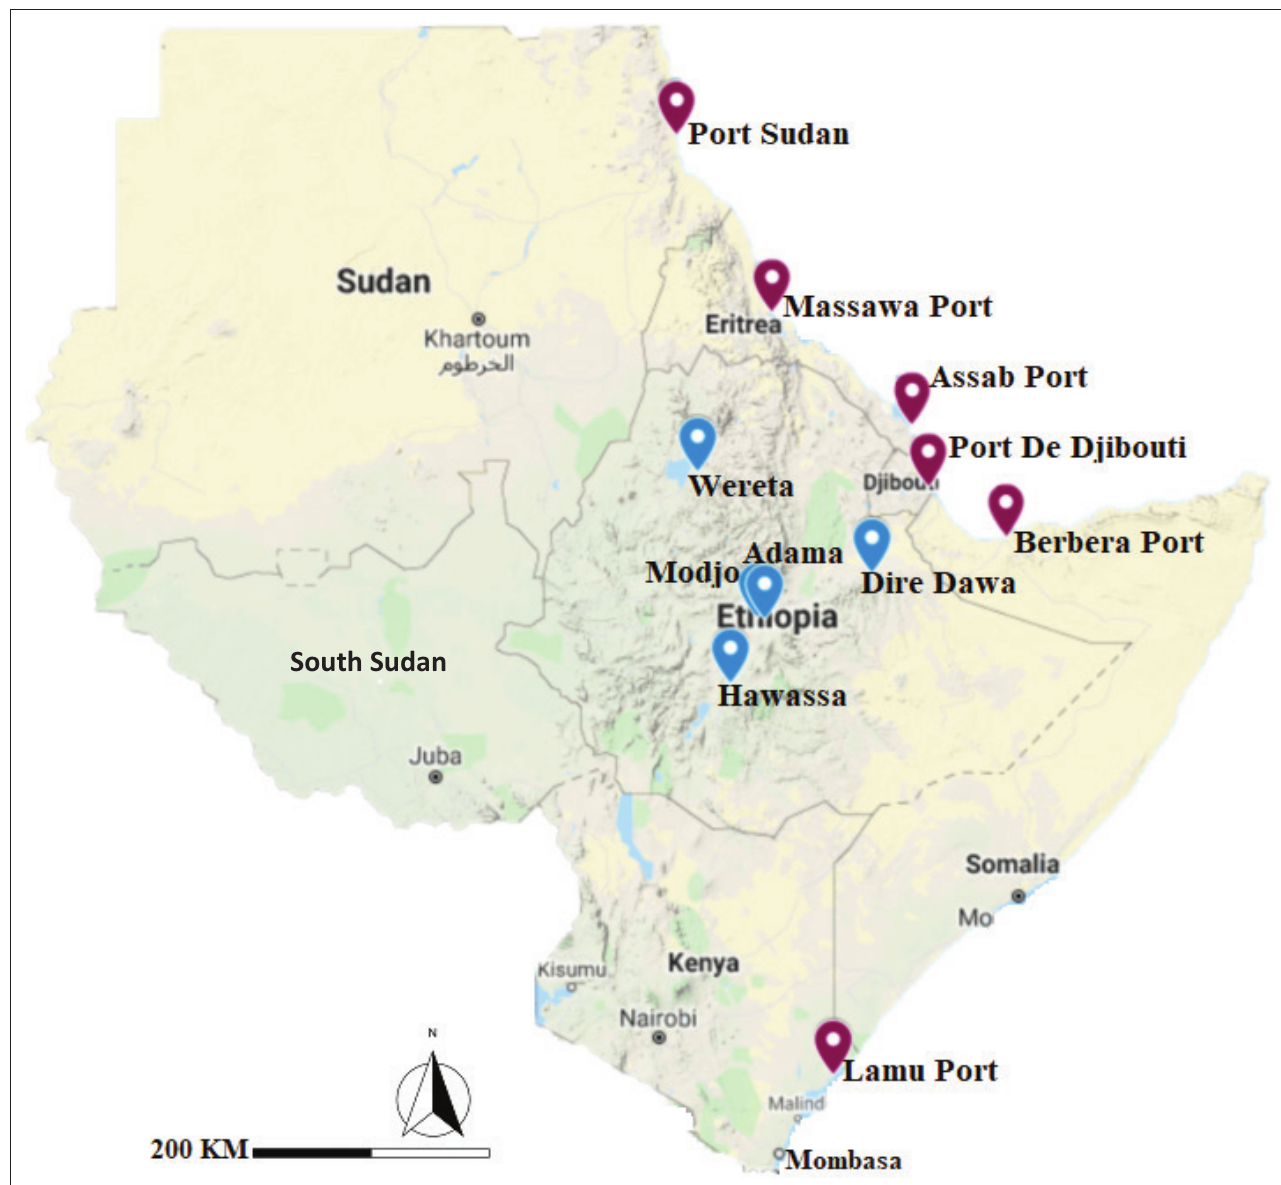
FIGURE 7: Location of seaports and inland destinations.